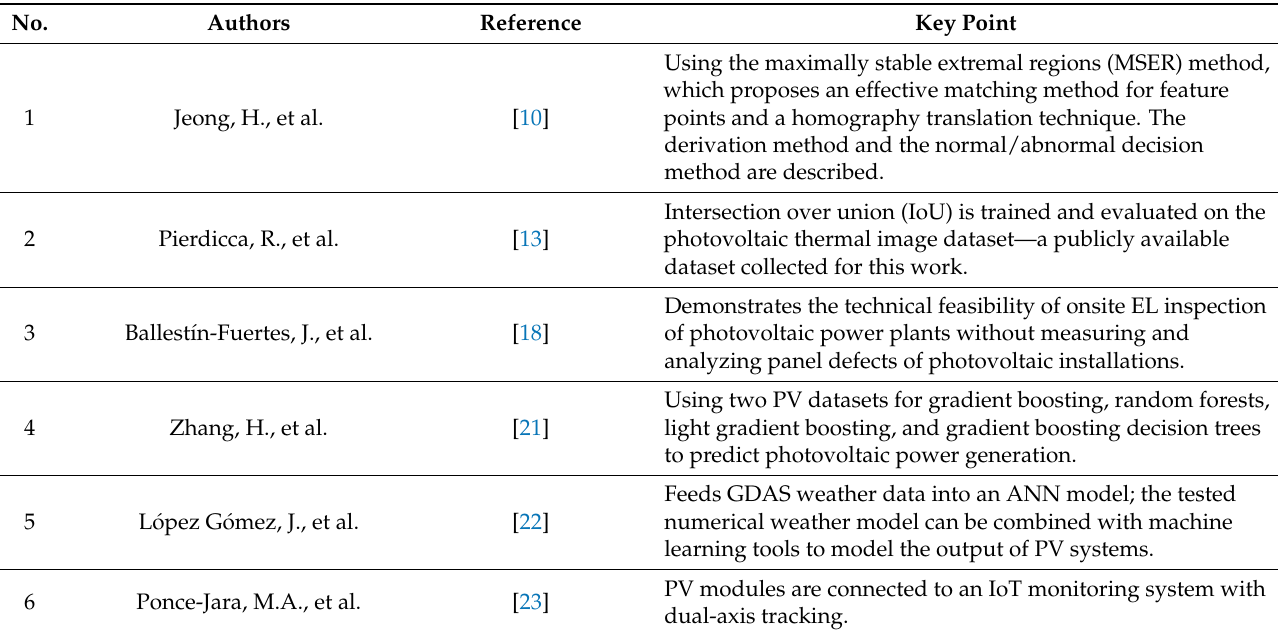
Table 2. Key points of each study in the literature